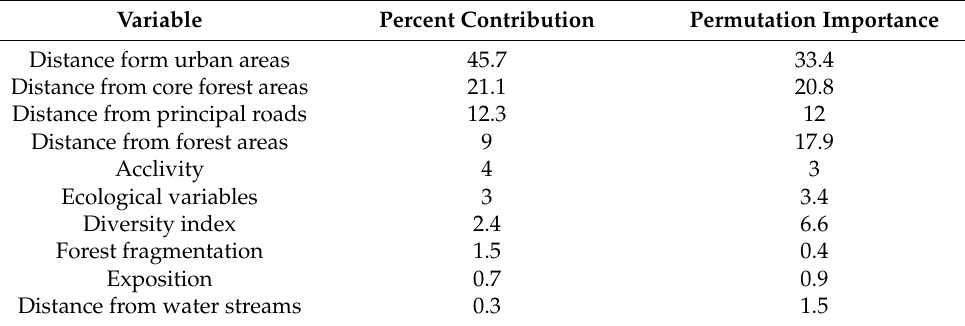
Table 4. Relative contributions of the environmental variables to the MaxEnt model.